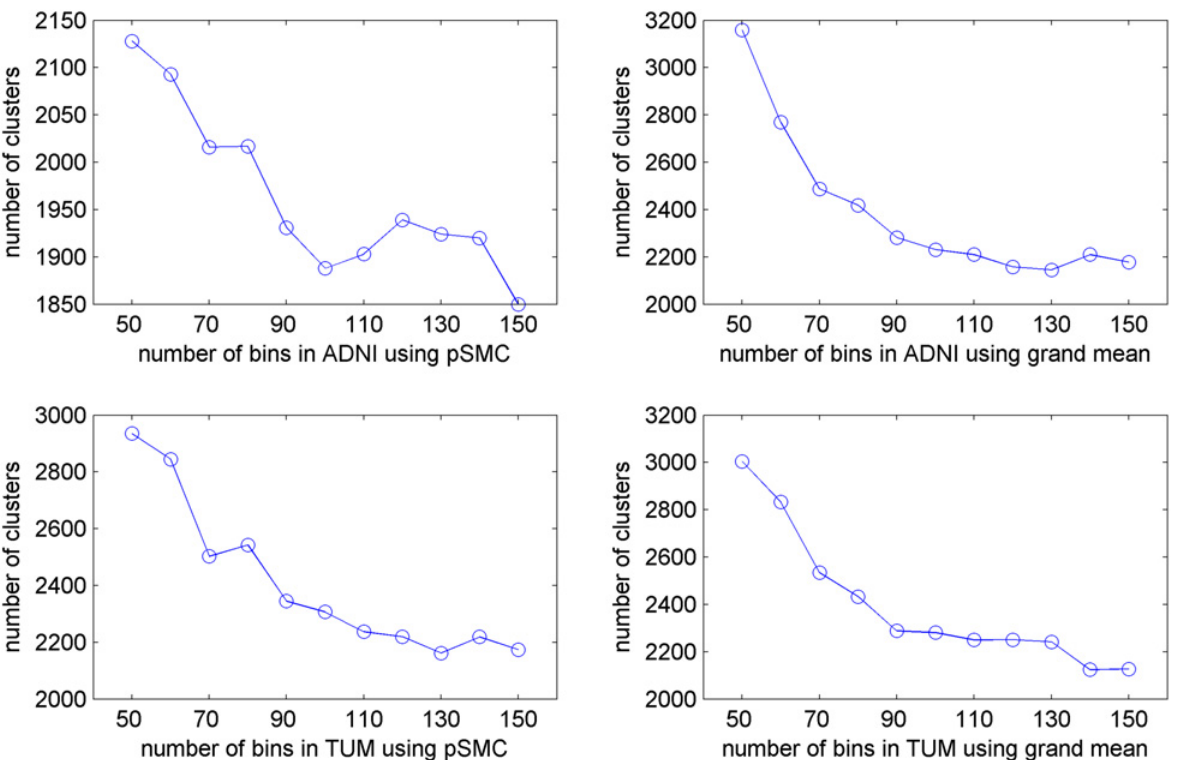
Fig 4. Relation between the number of clusters and the number of bins on ADNI and TUM datasets. Experiments are conducted on the normal control PET